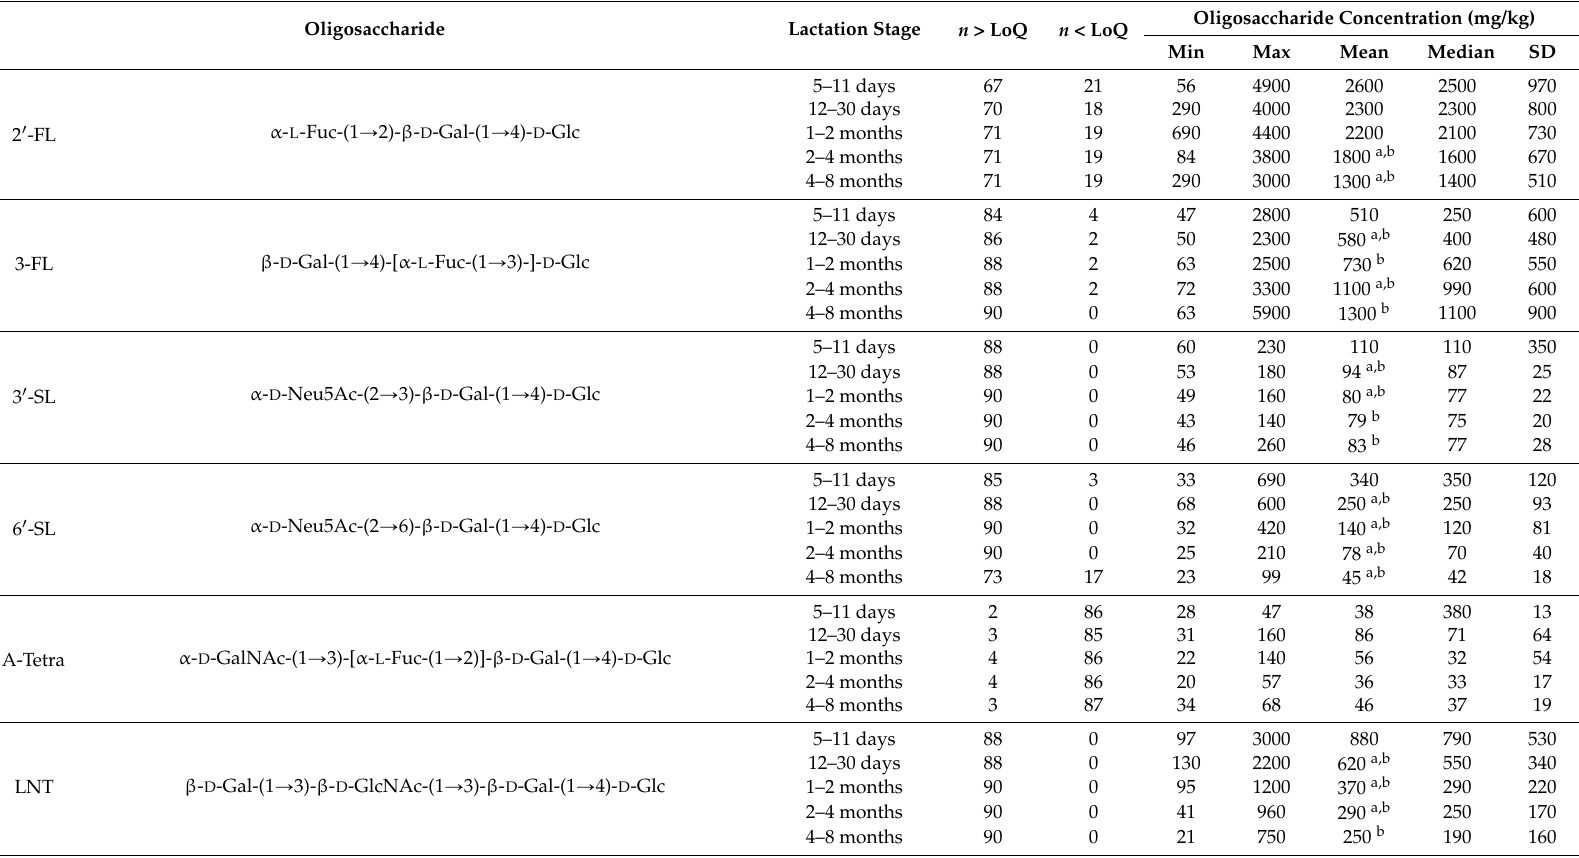
Table 4. Concentration of oligosaccharides in human milk, with samples having concentrations <LoQ removed from the dataset.